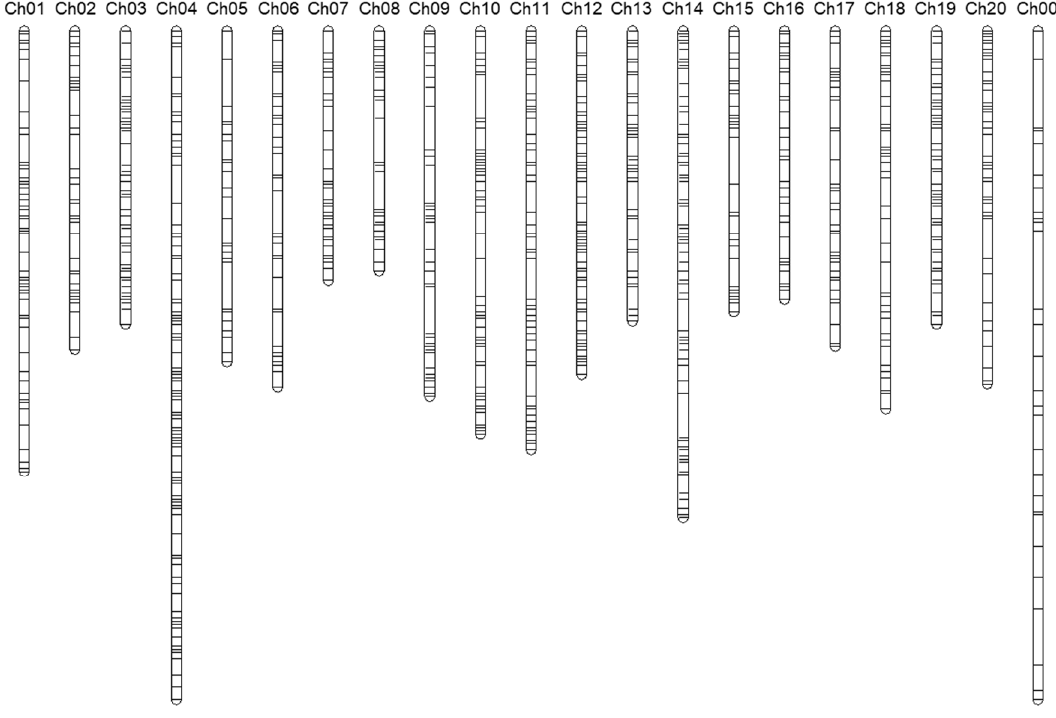
Table 1. Origin of the C. moschata germplasm collection among the three clusters inferred by the STRUCTURE analysis.